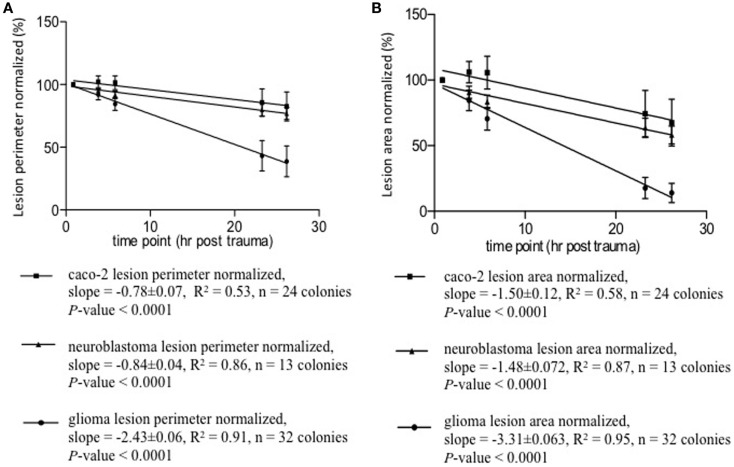
Lesion size–time relationships appear to be linear, see r2-values. A characterizing yet very approximate parameter of regeneration is the slope. Each line represents one cell type with its own slope. The slopes are significantly non-zero, all P-values <0.0001. (A) Lesion perimeter normalized mean ± SD (%) vs. time posttrauma (hours). (B) Lesion area normalized mean ± SD (%) vs. time posttrauma (hours).